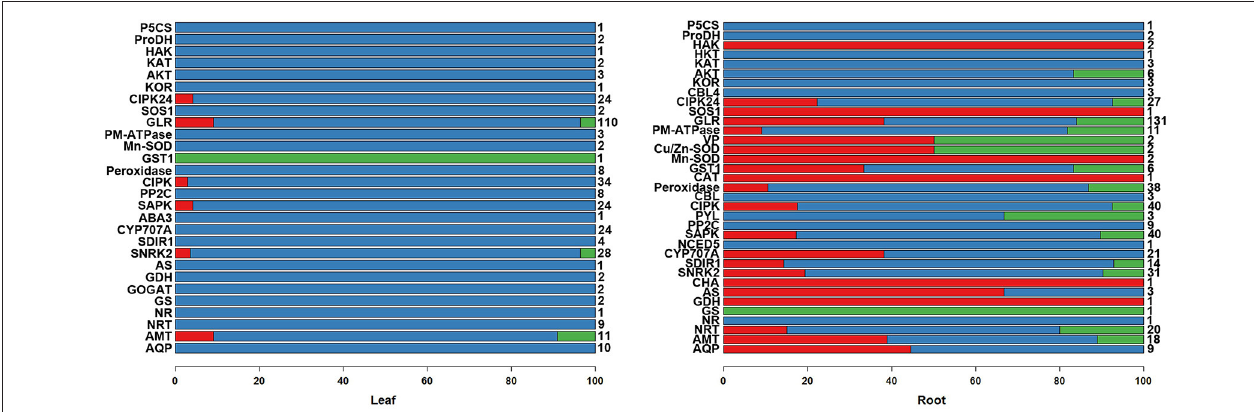
FIGURE 2 | The percentages of various response patterns of salinity-tolerant gene families to salinity stresses in the leaves and roots of K. sieversiana . Only differentially expressed genes were considered in the column diagram. The different members of each salinity-tolerant gene family were grouped into three response patterns: the expression was changed by only 80mM NaCl (red); only by 480mM NaCl (blue); by both 80 and 480mM NaCl (green). Total member numbers of the gene families are listed on the right of the column diagram. The 30-d-old seedlings were subjected to 0, 80, and 480mM NaCl for 2